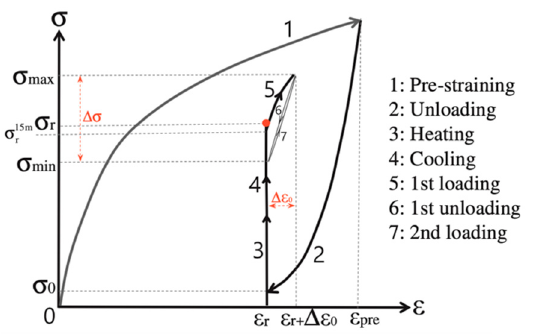
Figure 6. Cyclic loading path [40].